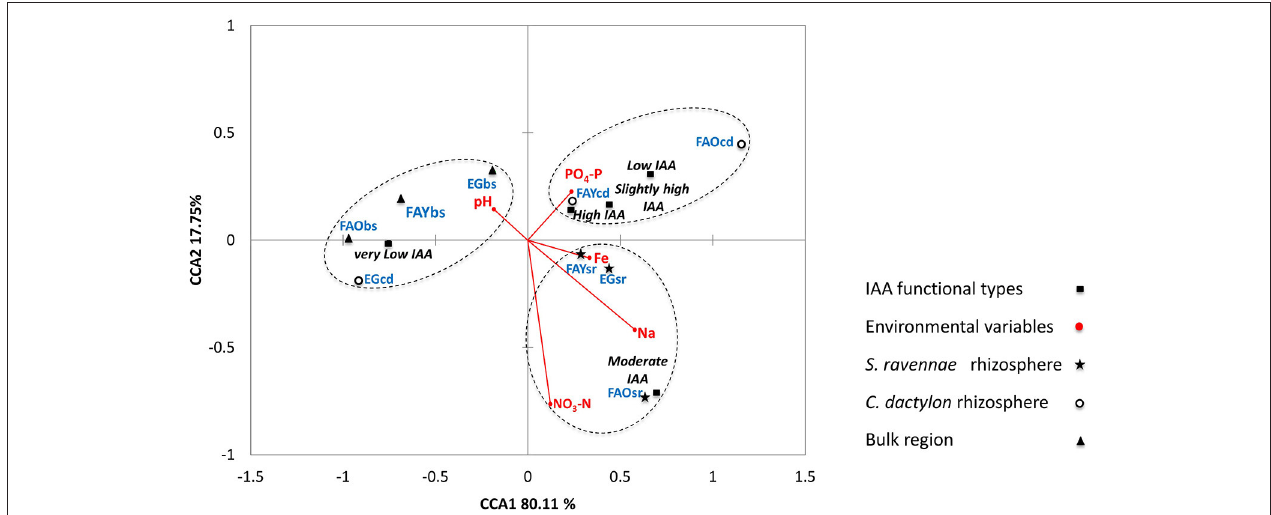
FIGURE 5 | Triplot of canonical correspondence analysis relating the IAA functional types (Very low, Low, Moderate, Slightly high, and High) from the rhizosphere of S. ravennae and C. dactylon, and non-rhizosphere (bulk) region from fly ash dumps of different ages and experimental garden, with environmental